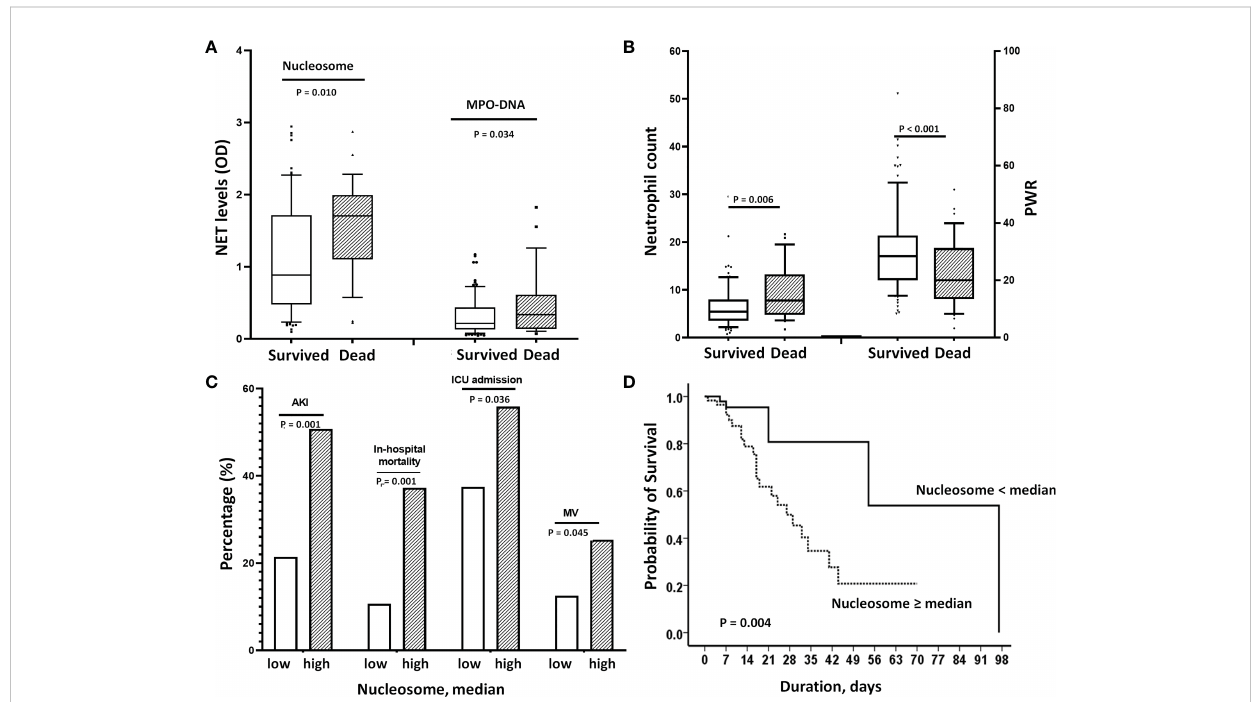
FIGURE 4 Effect of elevated NETs on mortality. (A) Nucleosome and MPO-DNA levels were signi fi cantly higher in patients who died than in those who survived [nucleosome: 1.78 (1.19-2.0 vs, 0.90 (0.47-1.68), p=0.010, MPO-DNA: 0.33 (0.12-0.5) vs. 0.21(0.13-0.38), p=0.034]. (B) Similarly, deceased patients had higher neutrophil counts (p=0.006) and lower PWRs (p<0.001) than survivors. (C) When nucleosome levels were divided into 2 groups according to median levels, patients in the high nucleosome group had worse clinical outcomes; signi fi cantly higher rates of AKI, in-hospital mortality, initial ICU admission and use of MV. (D) Kaplan-Meier analysis showed that higher nucleosome levels (>median) were associated with increased in-hospital mortality. In the adjusted Cox ’ s proportional hazards regression model, it signi fi cantly increased the risk by 3.2-fold. NET, neutrophil extracellular trap; PWR, platelet/WBC ratio; AKI, acute kidney injury; ICU, intensive care unit; BNP, MV, mechanical ventilation.